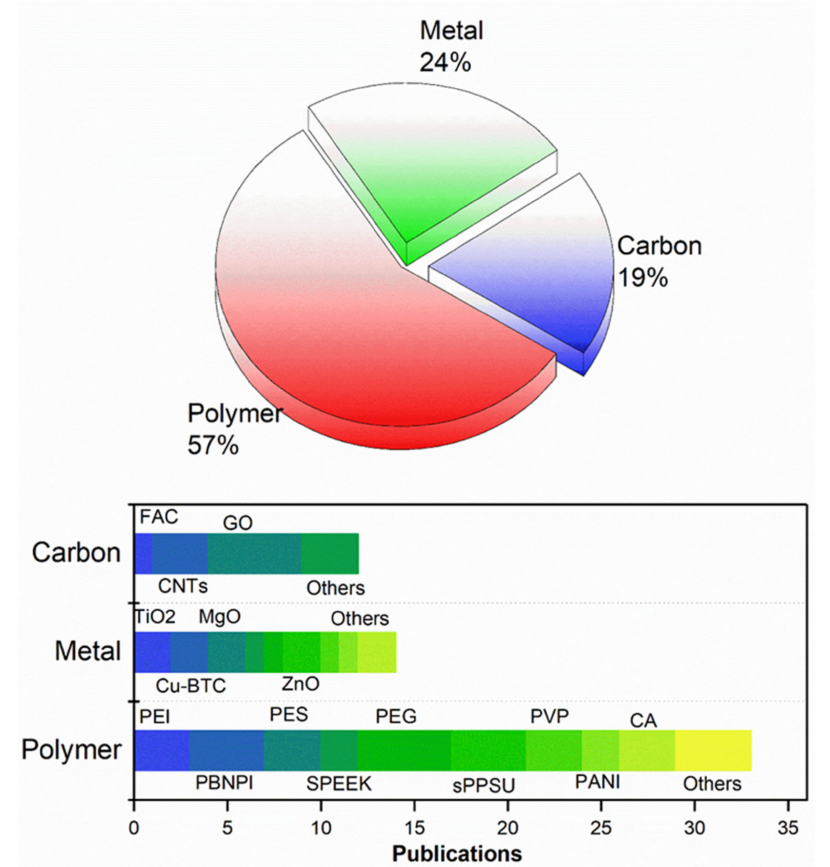
Figure 5. A number of articles on polyphenylsulfone blending indexed in Web of Science for “PPSU blend membrane”. Search results and details are provided in Table